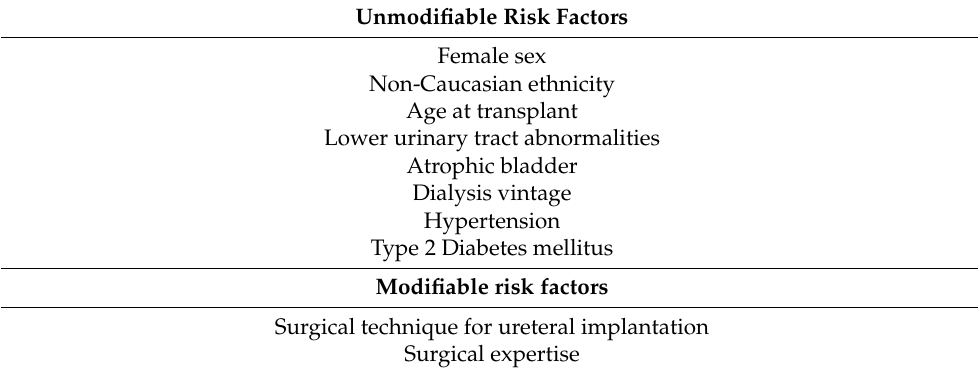
Table 1. Risk factors for post-transplant vesicoureteral